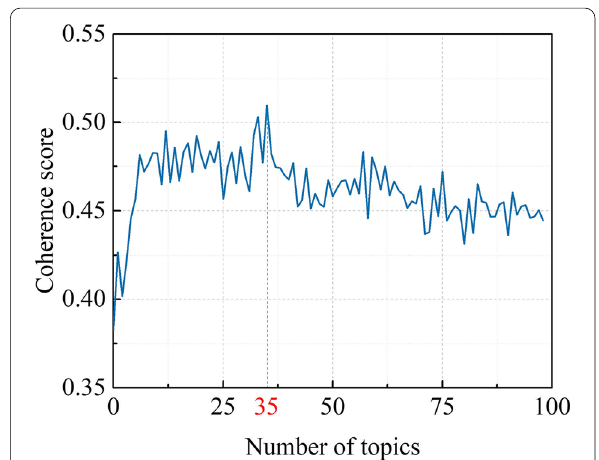
Fig. 7 Coherence score for different numbers of